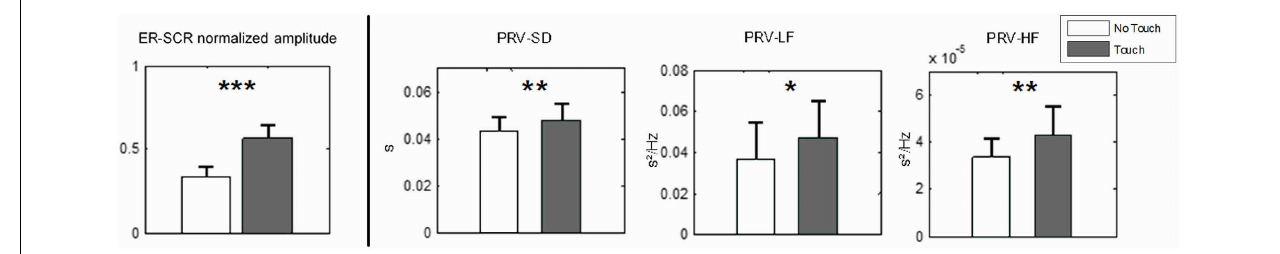
FIGURE 3 | Physiological measures at single-subject level (means with 95% CIs). Left: Electrodermal Activity, normalized amplitude of event-related skin conductance response at run’s beginning. Right: